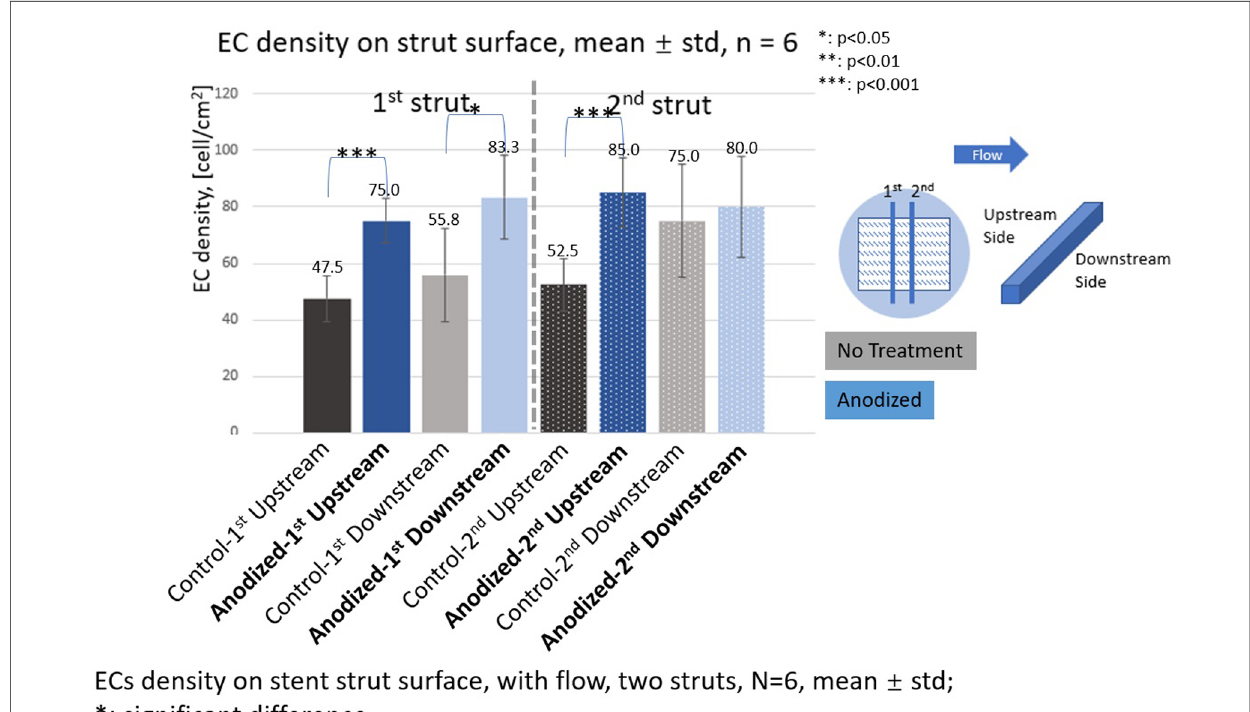
FIGURE 9 ECs density on stent strut surfaces, with fl ow 24-h, two struts, N =6, mean±std; T -test was performed to compare the signi fi cant difference (* p <0.05; ** p <0.01; *** p